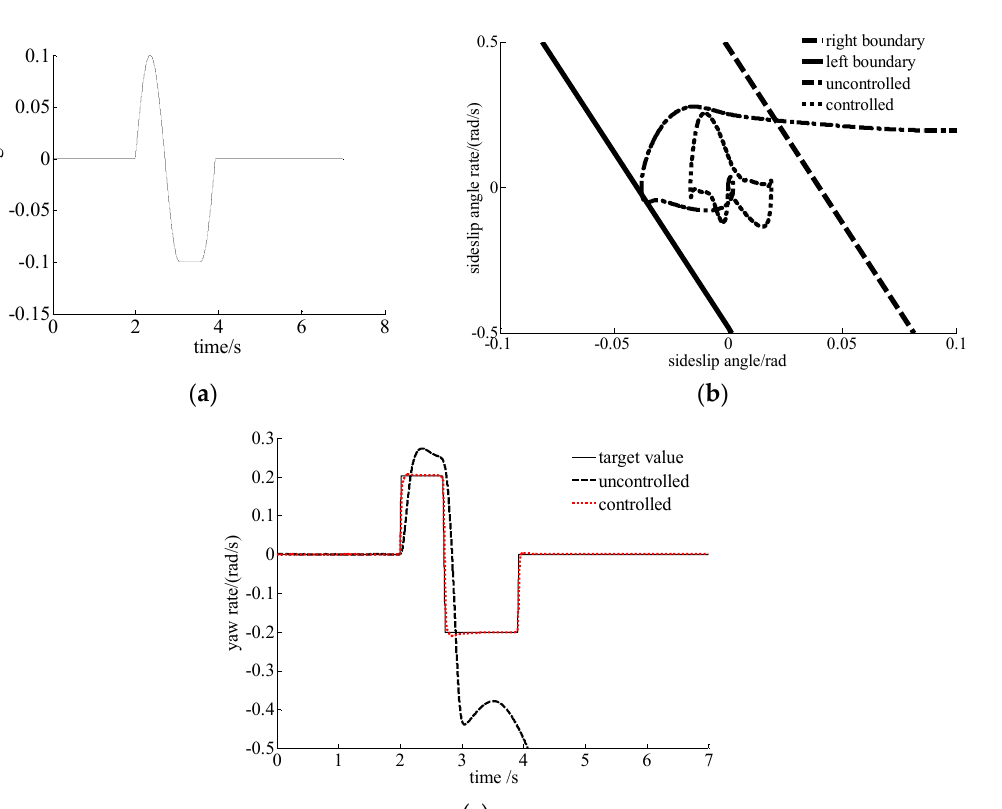
Figure 9. Simulation results of sinusoidal delay condition ( a ) front-wheel angle, ( b ) 𝛽 − 𝛽(cid:4662) phase plane of vehicle, and ( c ) yaw rate of vehicle.